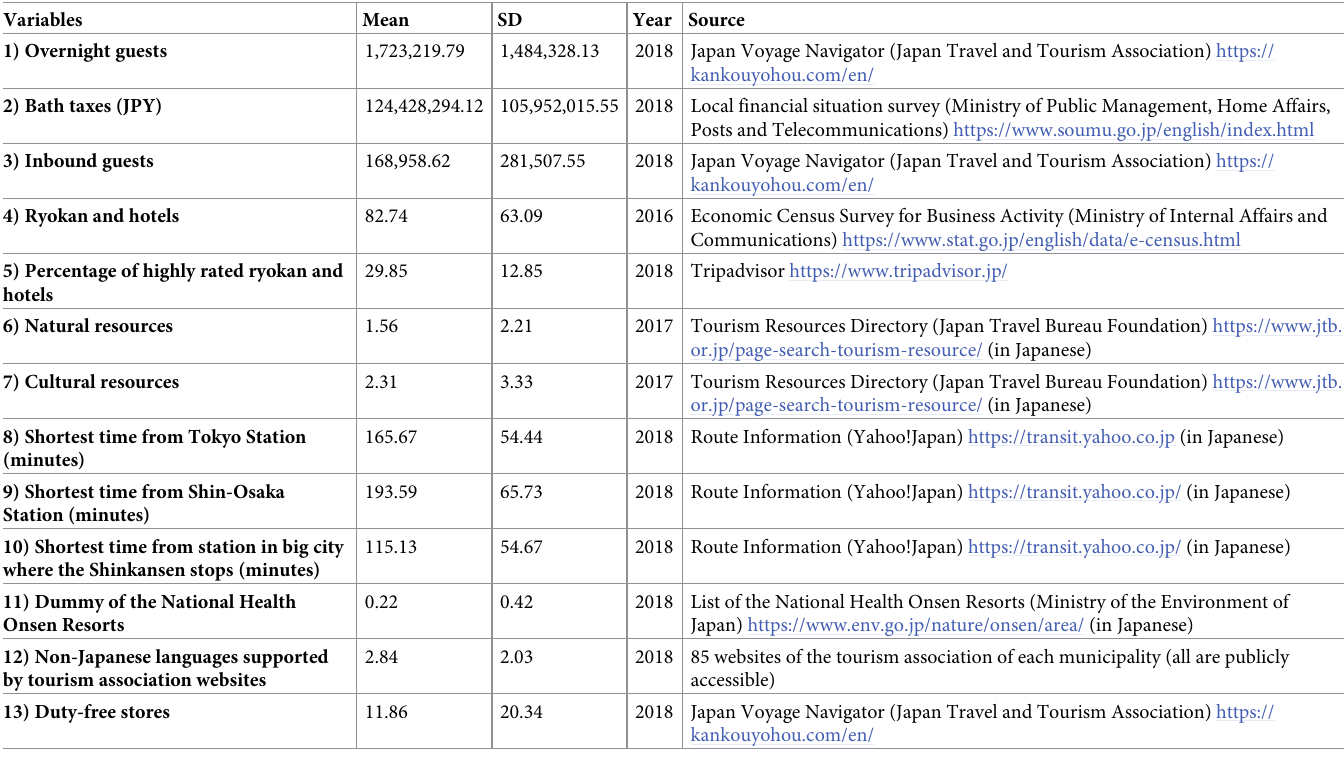
Table 2. Variables used in the present study and their